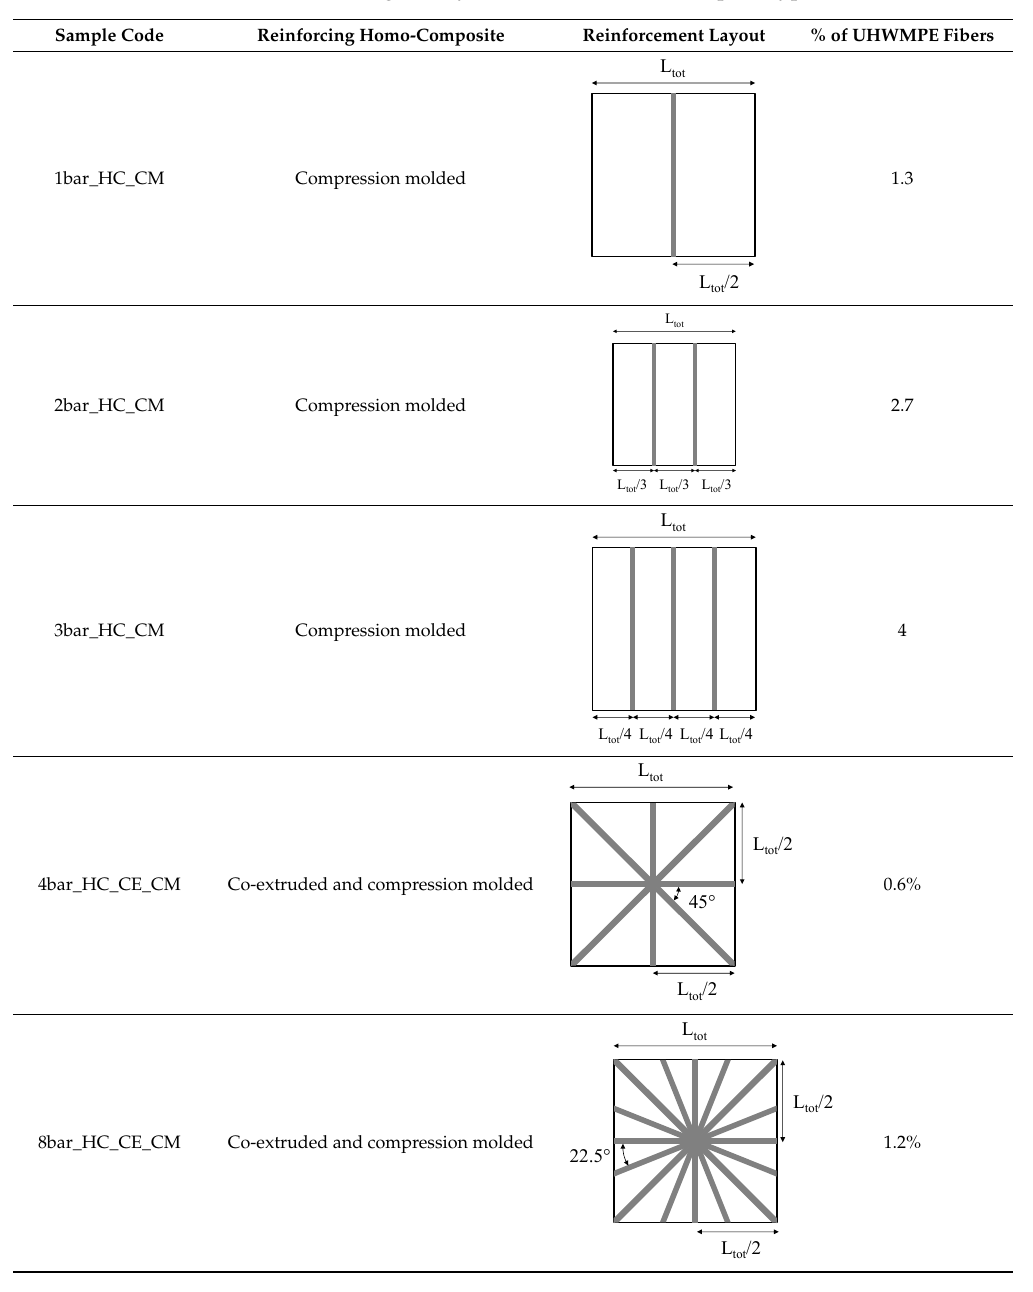
Figure 2. Picture of rotational molded homo-composite prototype. Table 1 . Reinforcing bar layout in rotational molded prototypes.